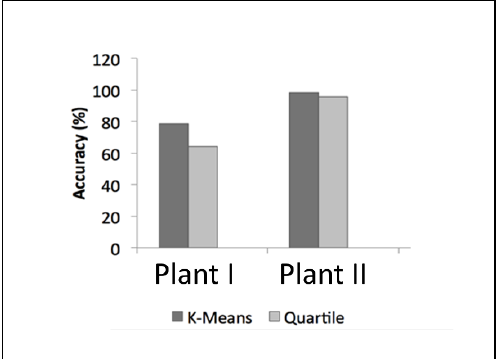
Figure 6. A comparison between the accuracy results of K-Means and quartile-based clustering using GMM as the splitting criterion. Table 5. Accuracy comparison between SVM vs. TWSVM with Decision Trees for K-means clustering as the initial label generator.